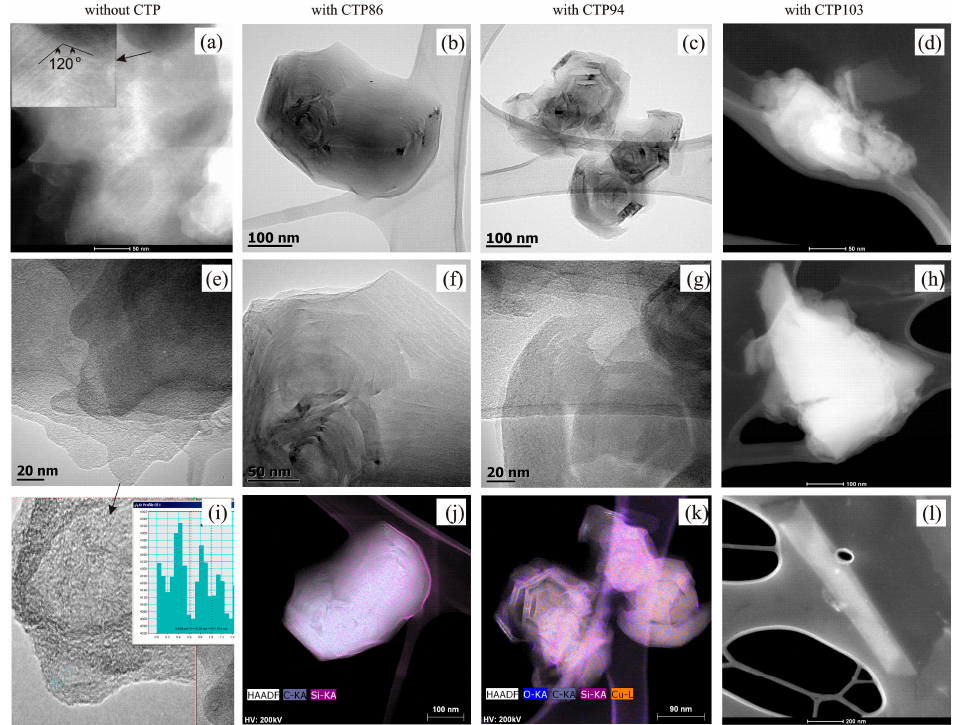
Figure 10. STEM-HAADF images of material that was extracted from the gas-saturated zones of investigated charges of coal and its blends with CTPs.